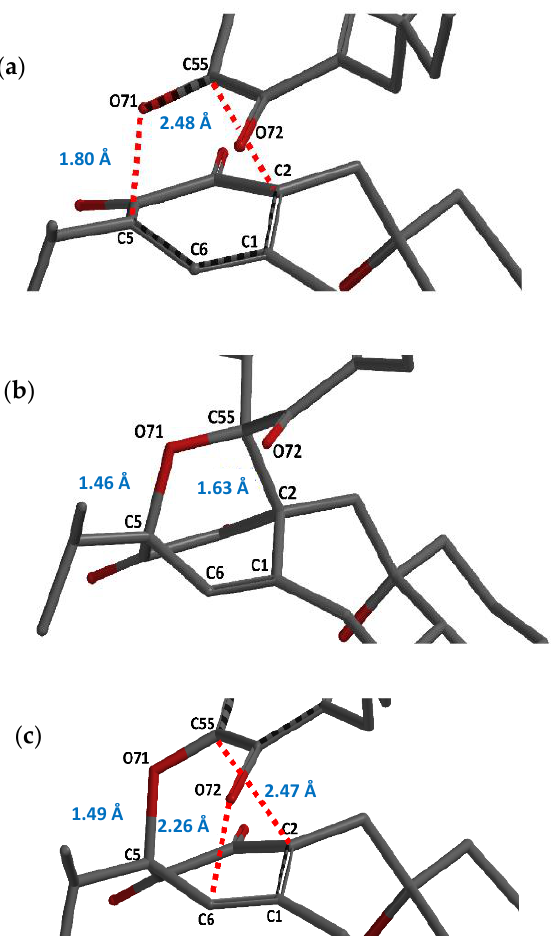
Figure 4. Structure of the TS1 ( a ) and the intermediate ( b ) and TS2 ( c ) transition states for the icetexane dimer grandione showing the main interatomic distances.